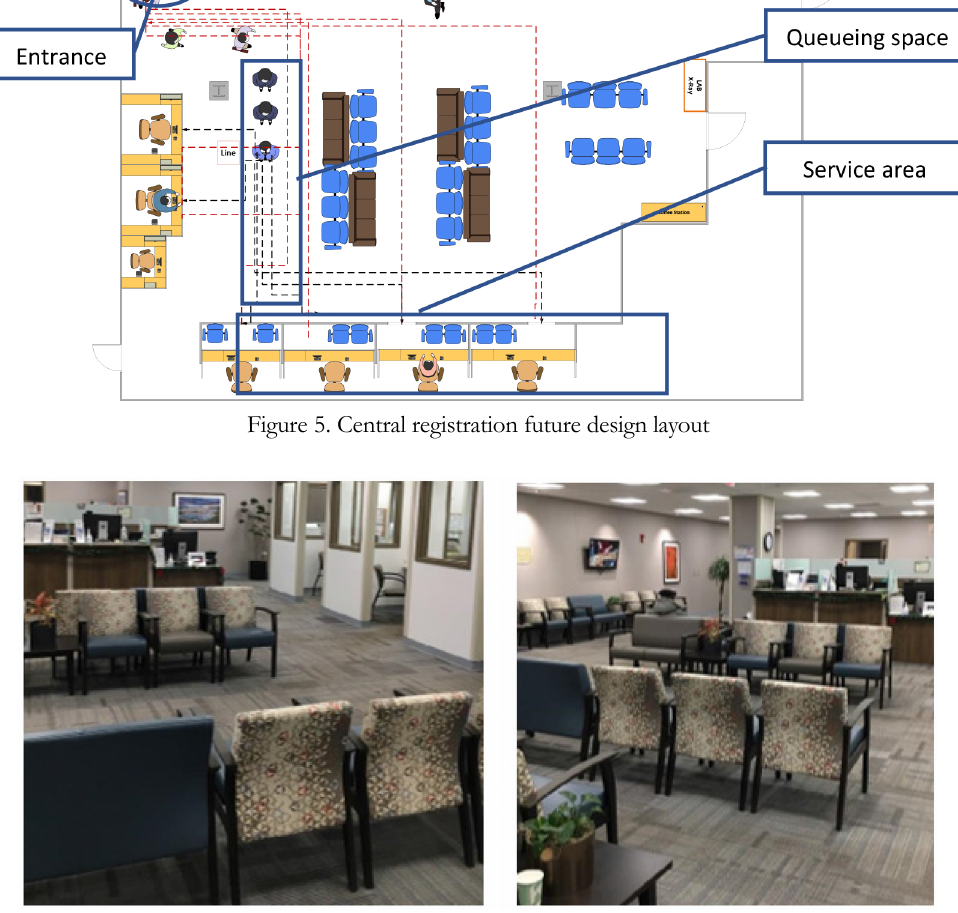
Figure 6 (a, b). CR area